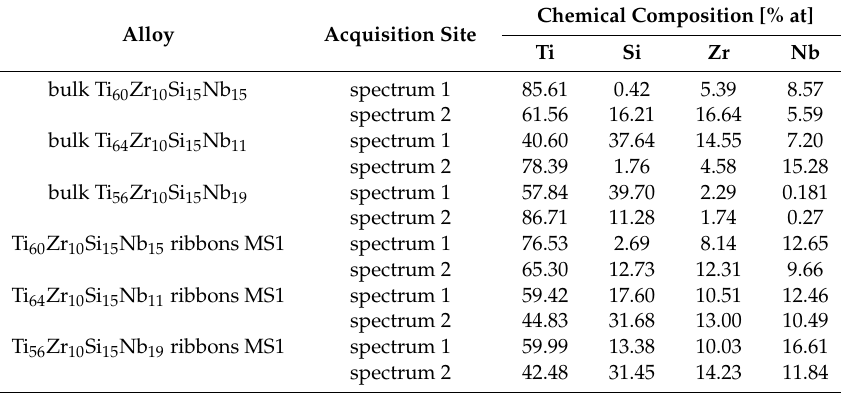
Table 3. Chemical composition as function of phase.